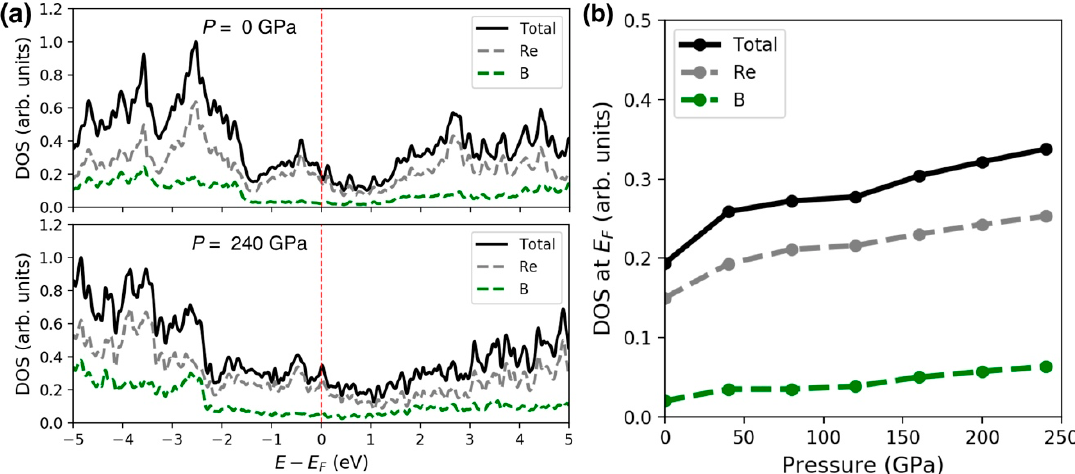
Figure 7. ( a ) ReB 2 density of states (DOS) plots at pressure P = 0 GPa (top) and 240 GPa (bottom), respectively. The Fermi level ( E F ) is indicated by the vertical dashed red line. ( b ) DOS at E F as a function of pressure.